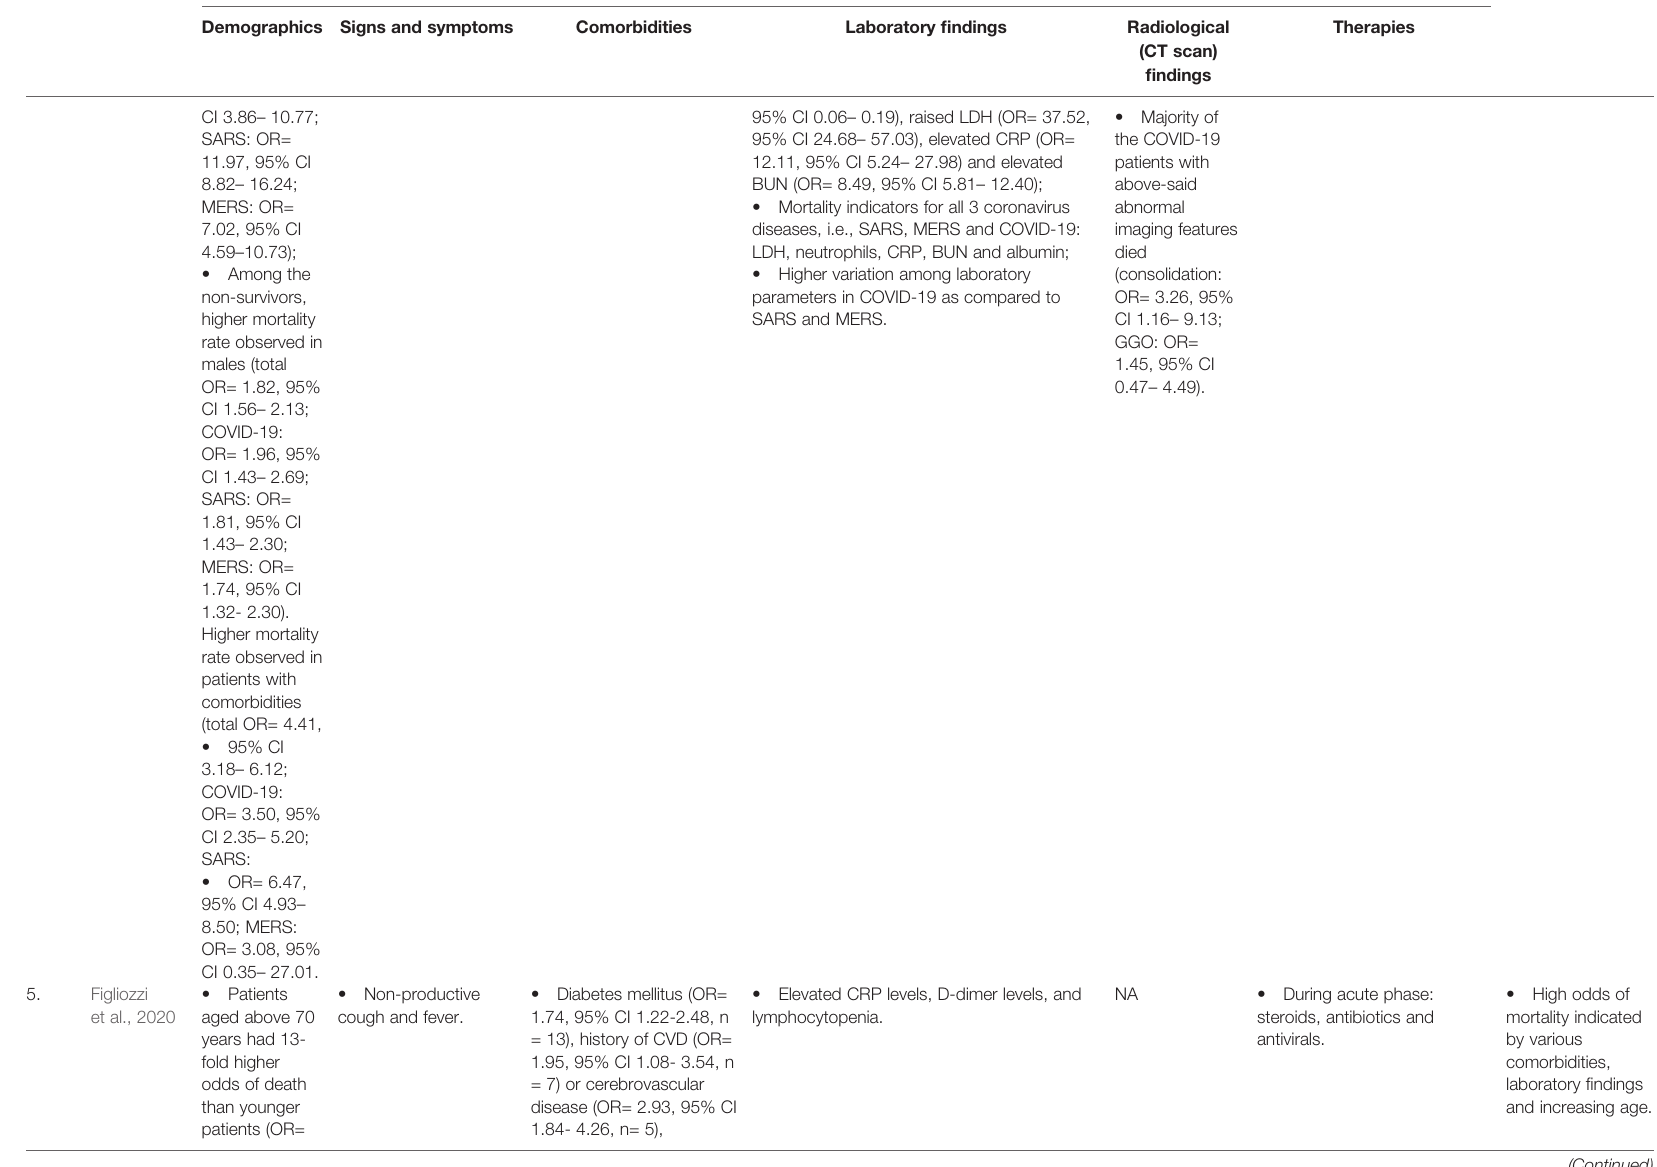
(cid:129) Patients aged above 70 years had 13- fold higher odds of death than